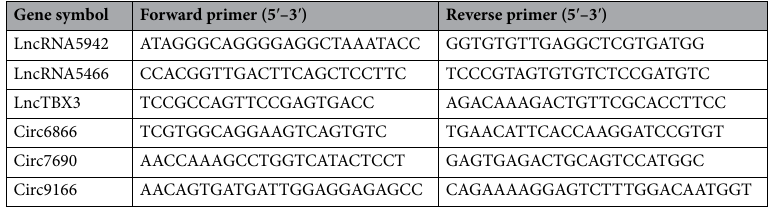
Table 3. Primers for quantitative real-time